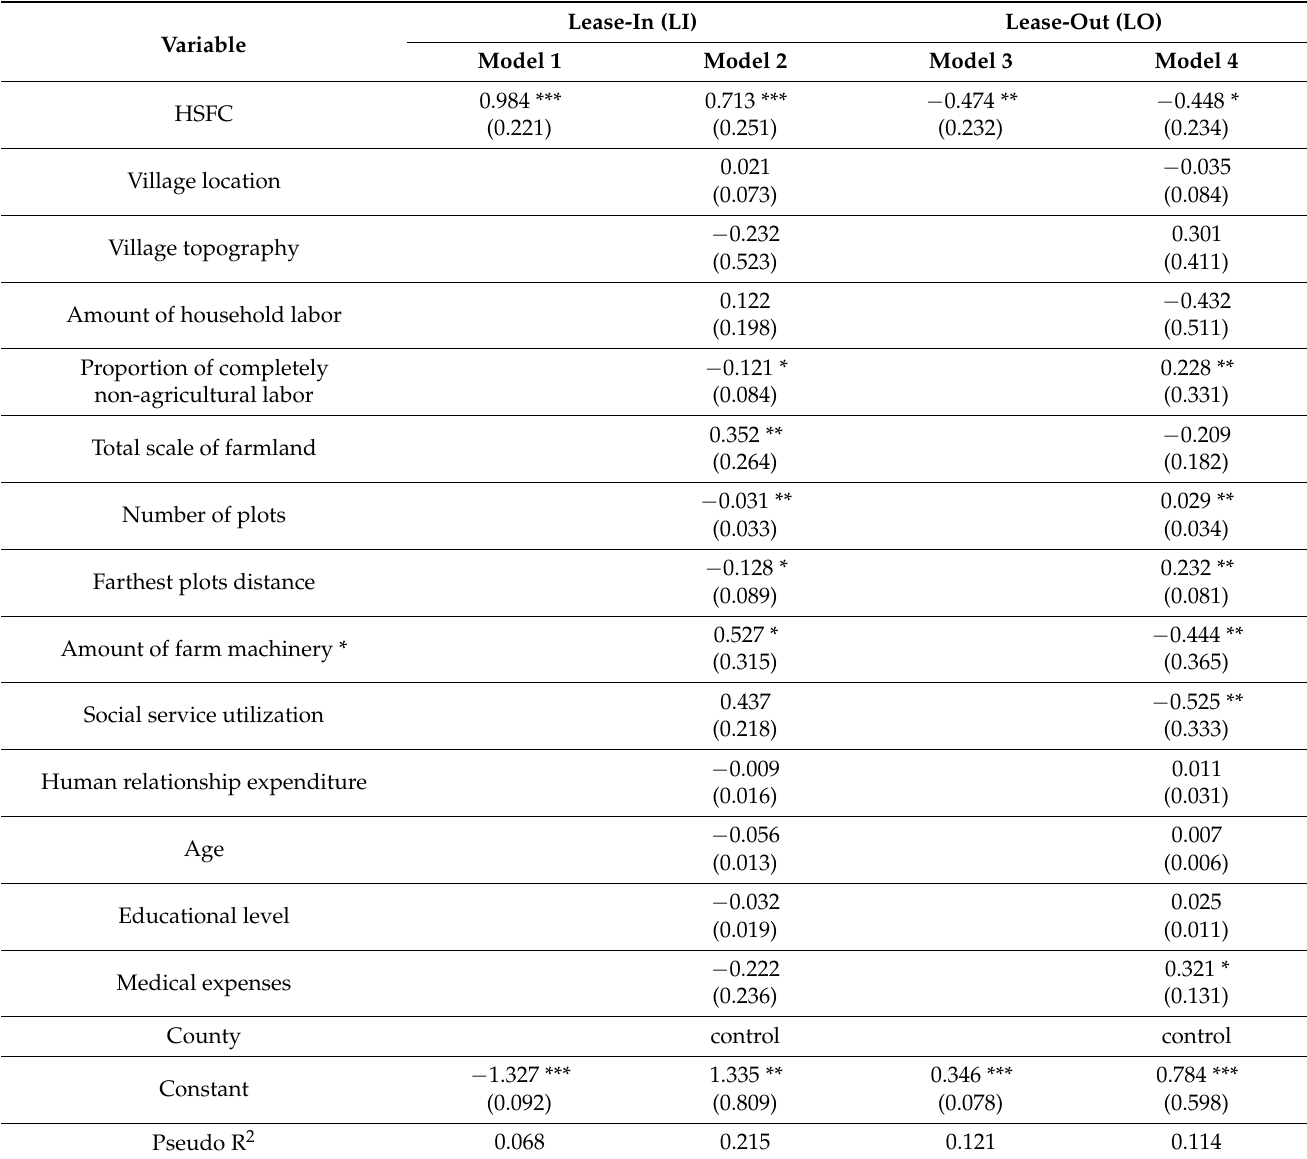
Table 2. Result of benchmark